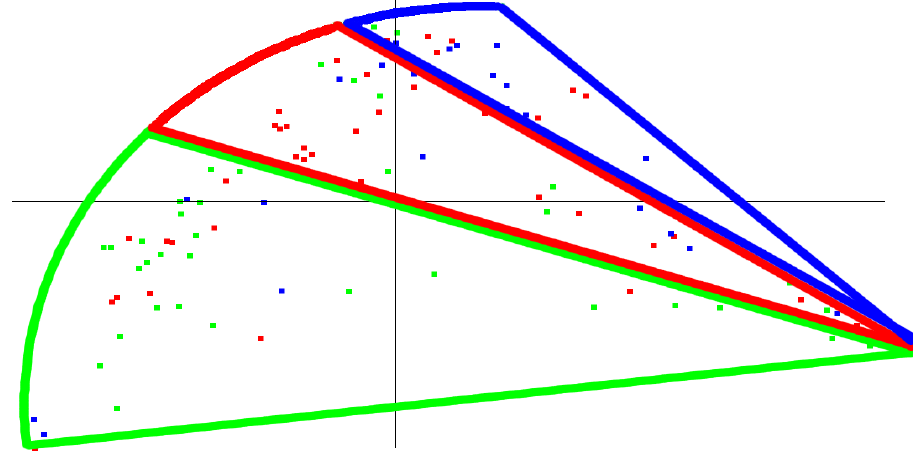
Figure 4. Clustering using the PLA index. Green corresponds to a low PLA index, red is medium, and blue is